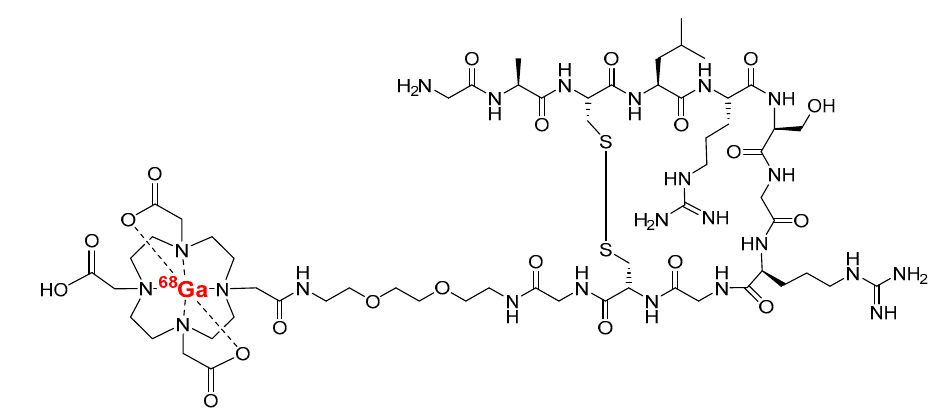
Figure 1. Structure of MMP-2/9 targeted [ 68 Ga]Ga-DOTA-TCTP-1 tracer (Cys 3-10 ; H-Gly-Ala-Cys-Leu- Arg-Ser-Gly-Arg-Gly-Cys-Gly-PEG(3)-DOTA- 68 Ga). DOTA, 1,4,7,10-tetraazacyclododecane-1,4,7,10- tetraacetic acid; PEG, polyethylene glycol.